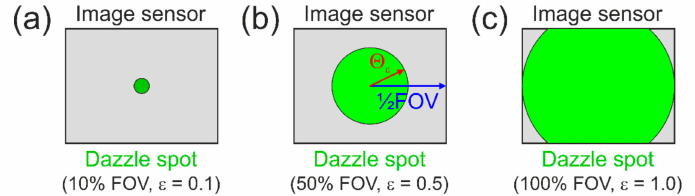
Figure 10. Definition of the dazzle level as fraction of the sensor’s field of view that is